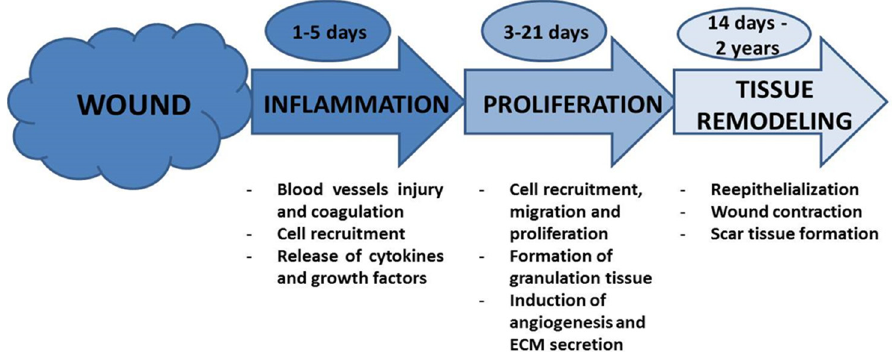
Figure 2. Normal wound healing stages with the main events